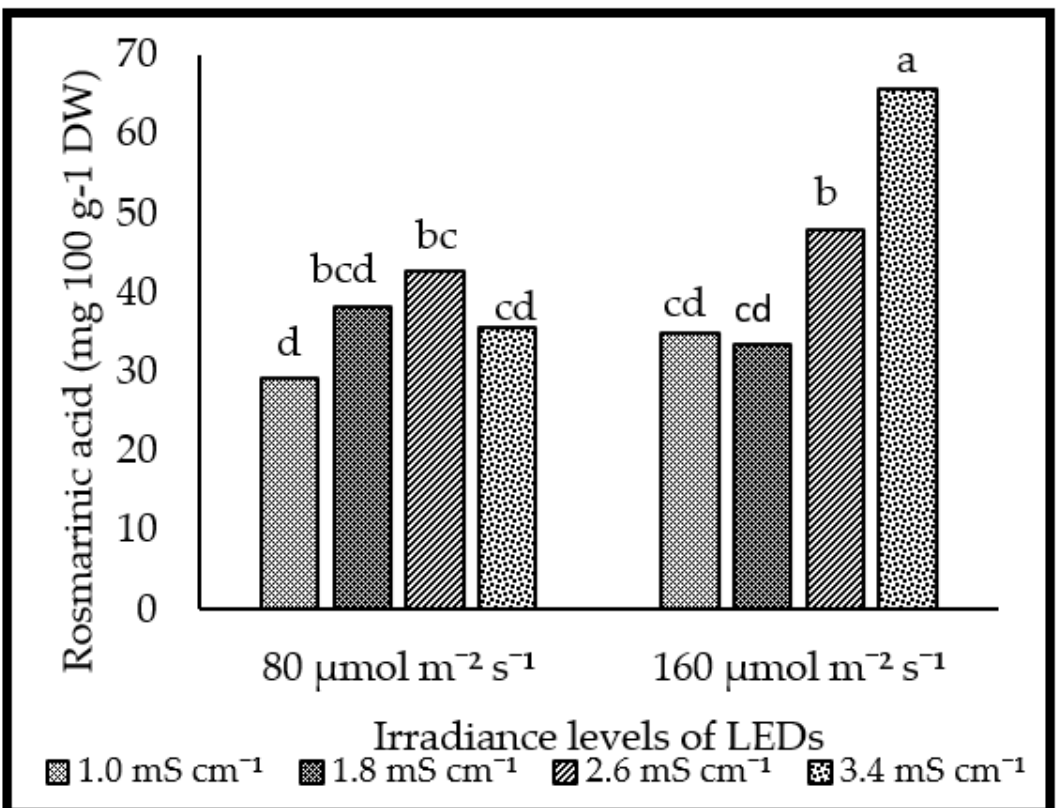
Figure 9. Interaction effect of LED irradiance levels and nutrient solution EC on rosmarinic acid in lemon